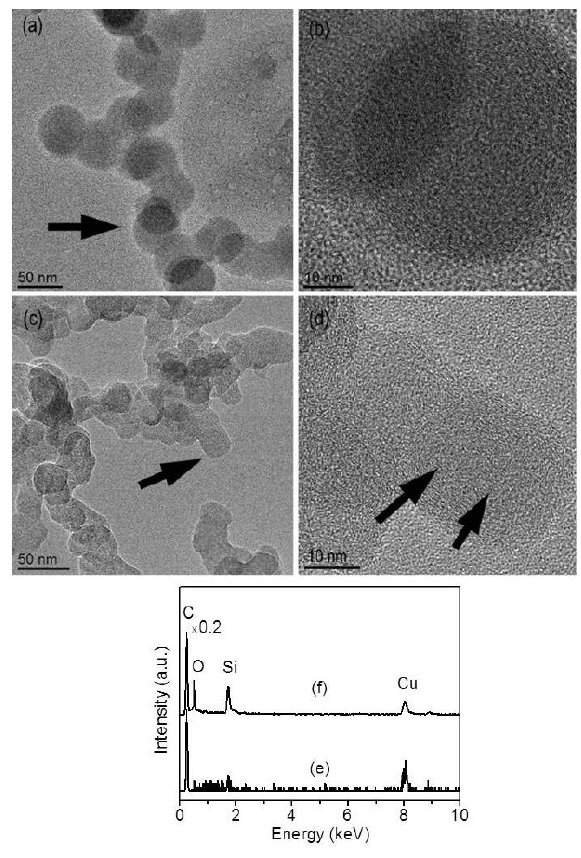
Figure 2. Soot collected at 120 m altitude. (a) TEM image of a soot aggregate attached on carbon film and (b) HRTEM image from the arrowed area. (c) Soot spherules attached on amorphous carbon and (d) their HRTEM image from the arrowed area. (e) EDS results from the soot in image (a). The intensity of carbon peak is multiplied by factor of 0.2 for comparison with the weak signals from other elements.